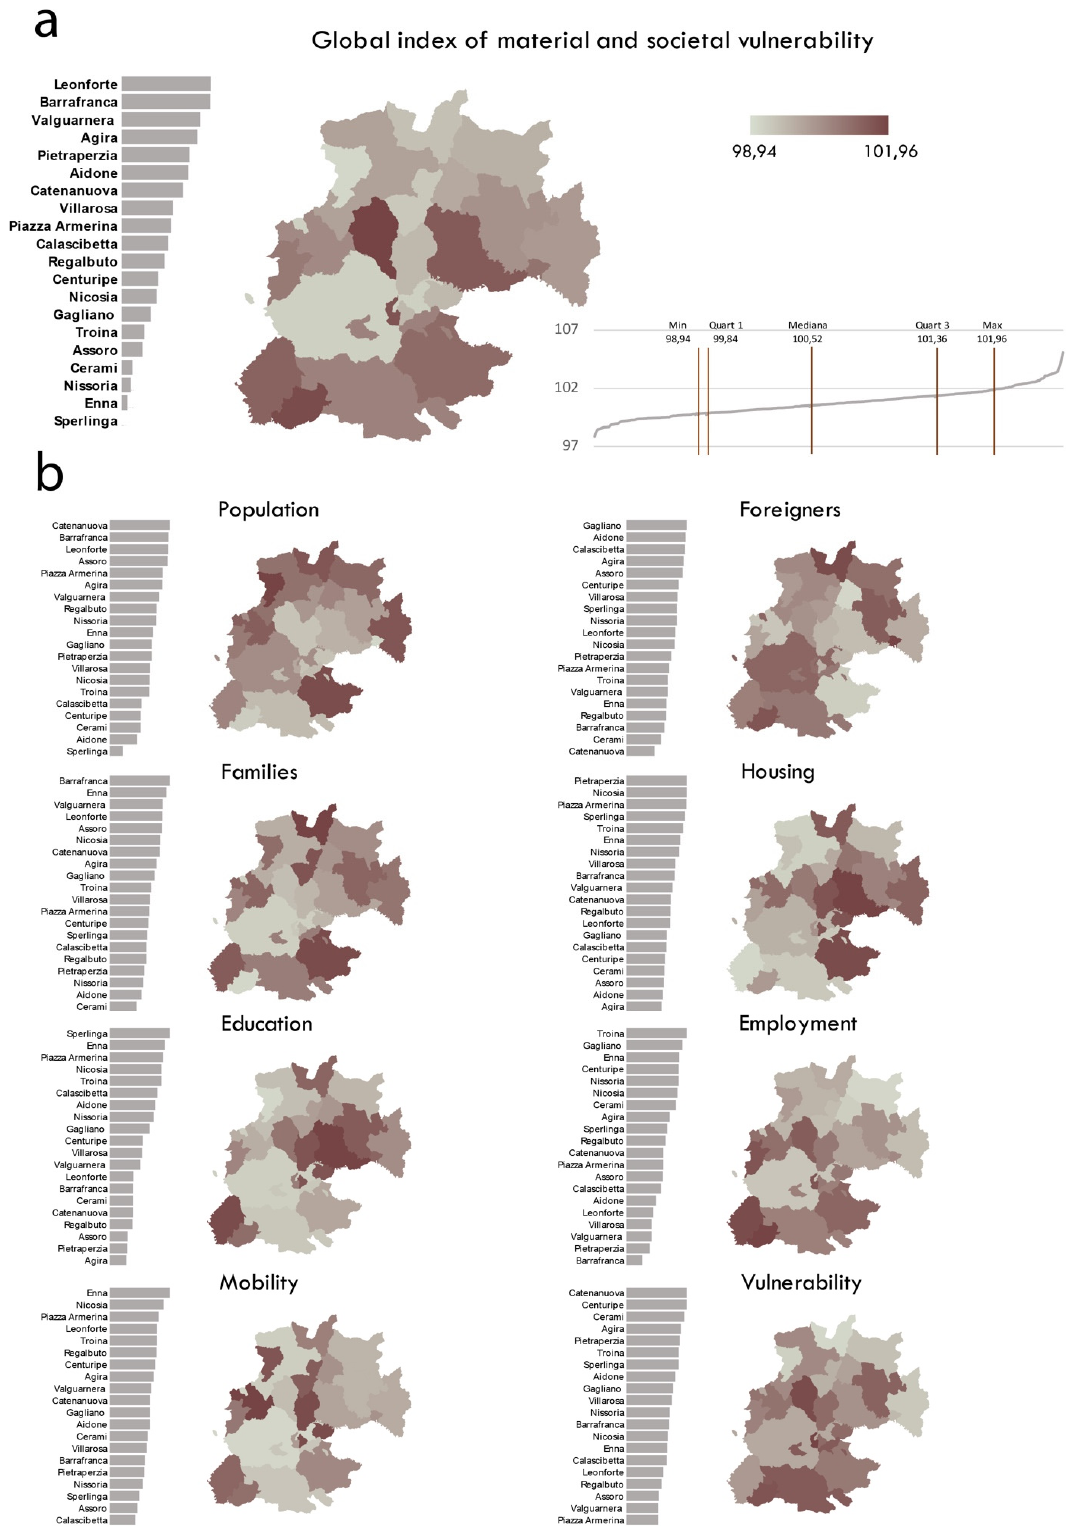
Figure 3. Rankings of the Municipalities from the perspective of the location territorial equilibrium indi- ces (numerical values under the colour ramp): ( a ) overall score; ( b ) scores for each detailed index.